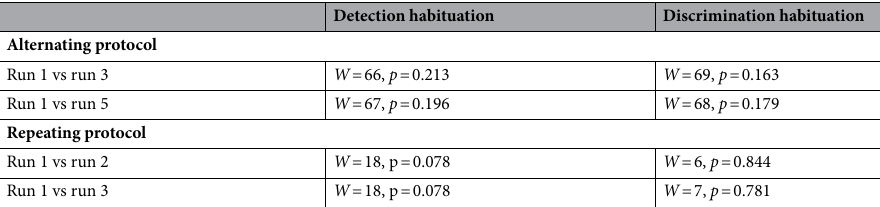
Table 1. Statistical testing output on whether there was significant reduction in response amplitude due to long-term adaptation. Comparisons between runs are made as illustrated in Fig. 9; A signed-rank test was run and the test statistic and p values are